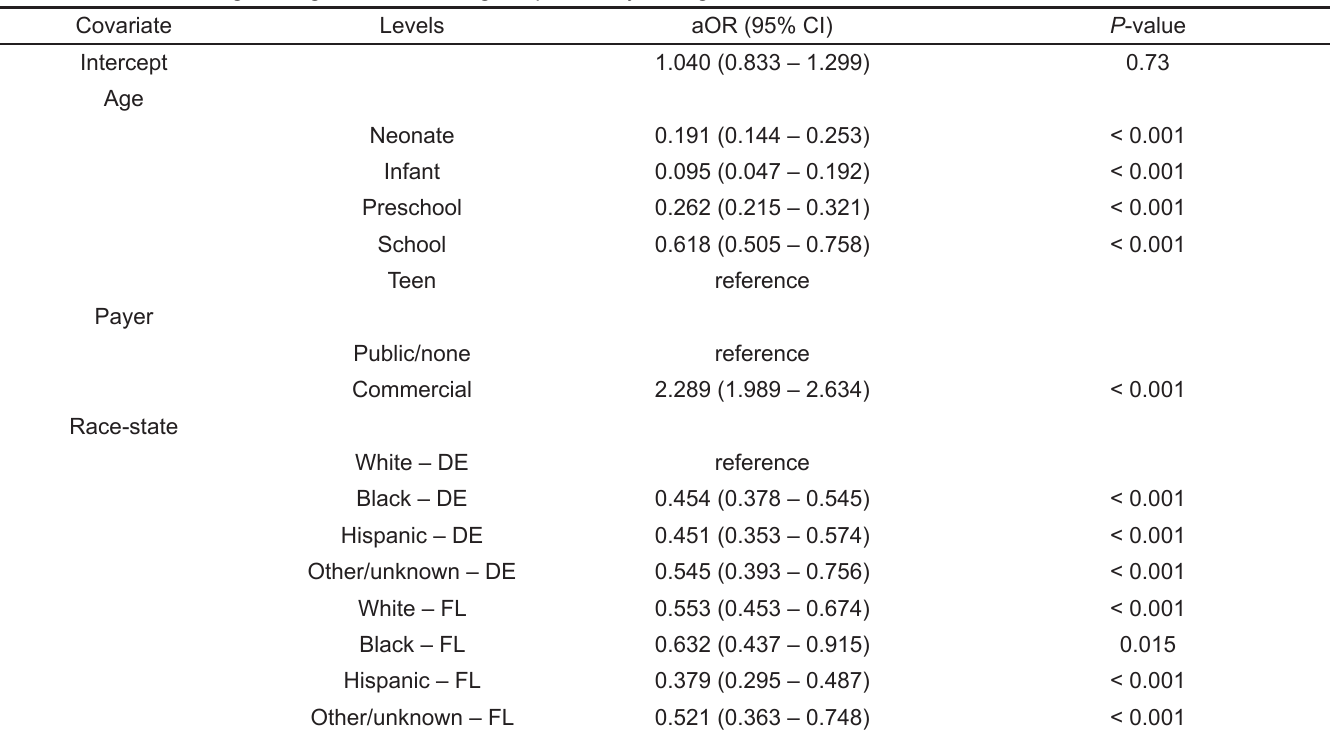
Table 3a. Multinomial logistic regression modeling the probability of “urgent” visits.